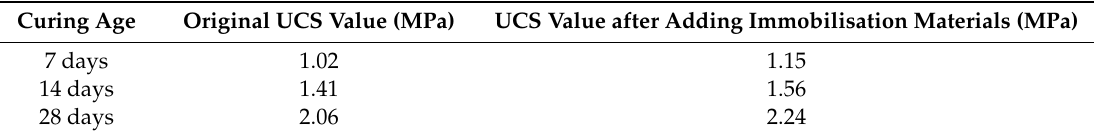
Table 6. Unconfined compressive strength (UCS) variation of cemented paste backfill (CPB) samples with a cement/tailing ratio of 1:6 and slurry concentration of 72%.